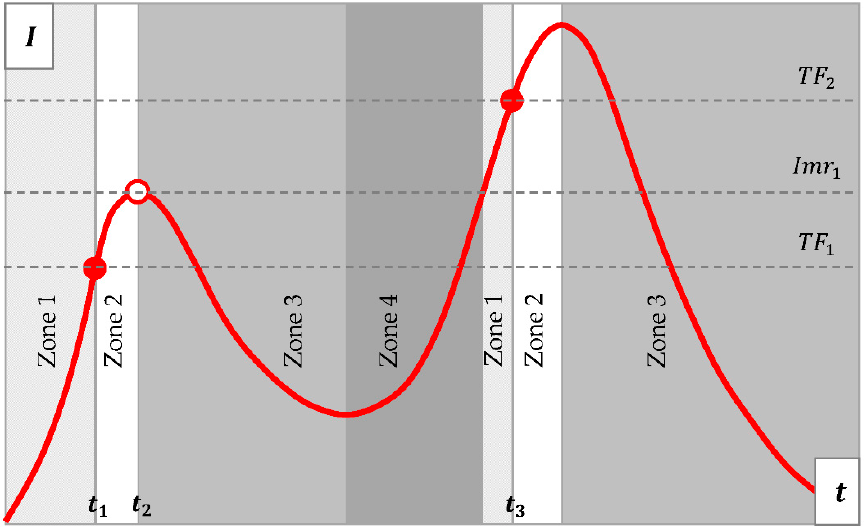
Figure 5. Zoning based on the input hydrograph to the reservoir of a single criterion for selecting the flow discharged in each zone, according to Figure 6 and the following steps: